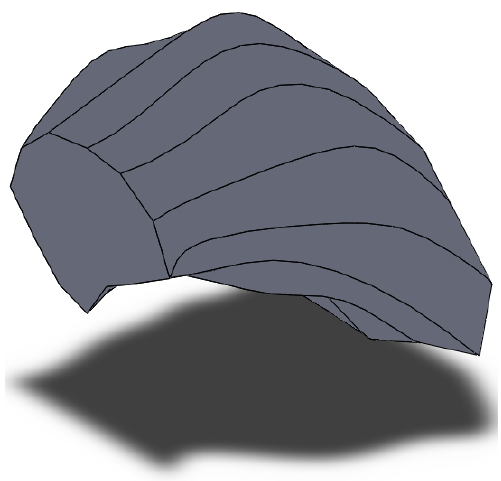
Figure 5. Cross-section of the grain ( a ) and its contour as a polygon sketch in SolidWorks ( b ).